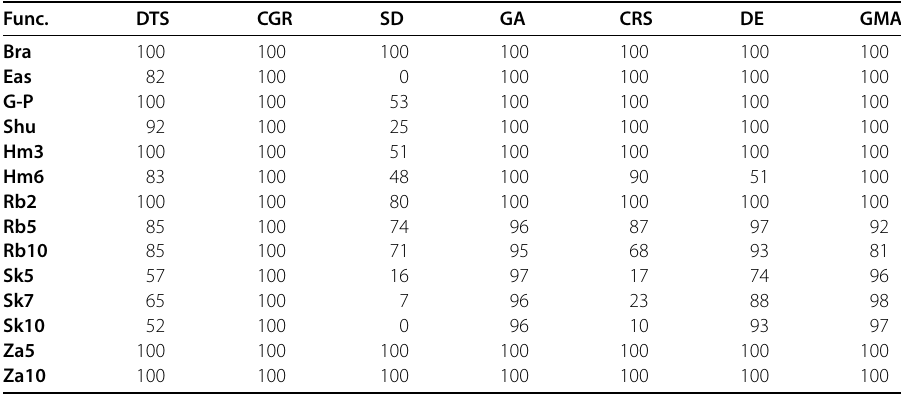
Table 1 Success rate (%) of the optimization algorithms when solving the considered benchmark problems ( Func ) Func.